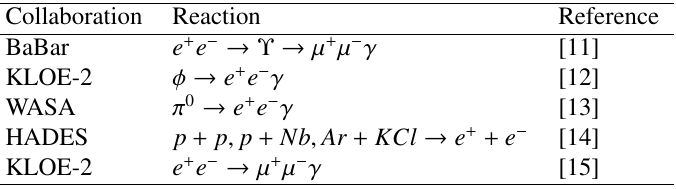
Table 1. Please write your table caption